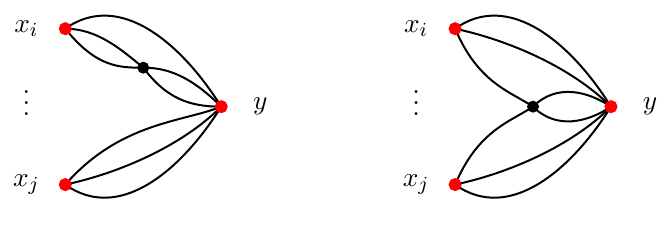
Figure 1 . Types of diagrams that contribute to the extremal